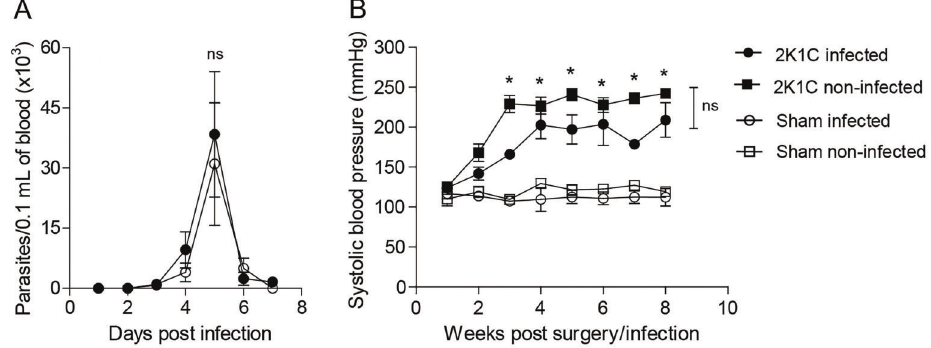
Figure 1. Parasitemia and systolic blood pressure. Wistar rats were subjected to two-kidney, one-clip (2K1C) (n=8) renovascular hypertension or SHAM normotensive (n=8) surgery and infected or not with 1.2 (cid:1) 10 6 trypomastigote forms of T. cruzi Y strain. Parasitemia was measured daily ( A ) and systolic blood pressure was measured weekly ( B ). Data are reported as means ± SE. *P o 0.05 compared with the Sham groups (two-way ANOVA). ns: not signi fi